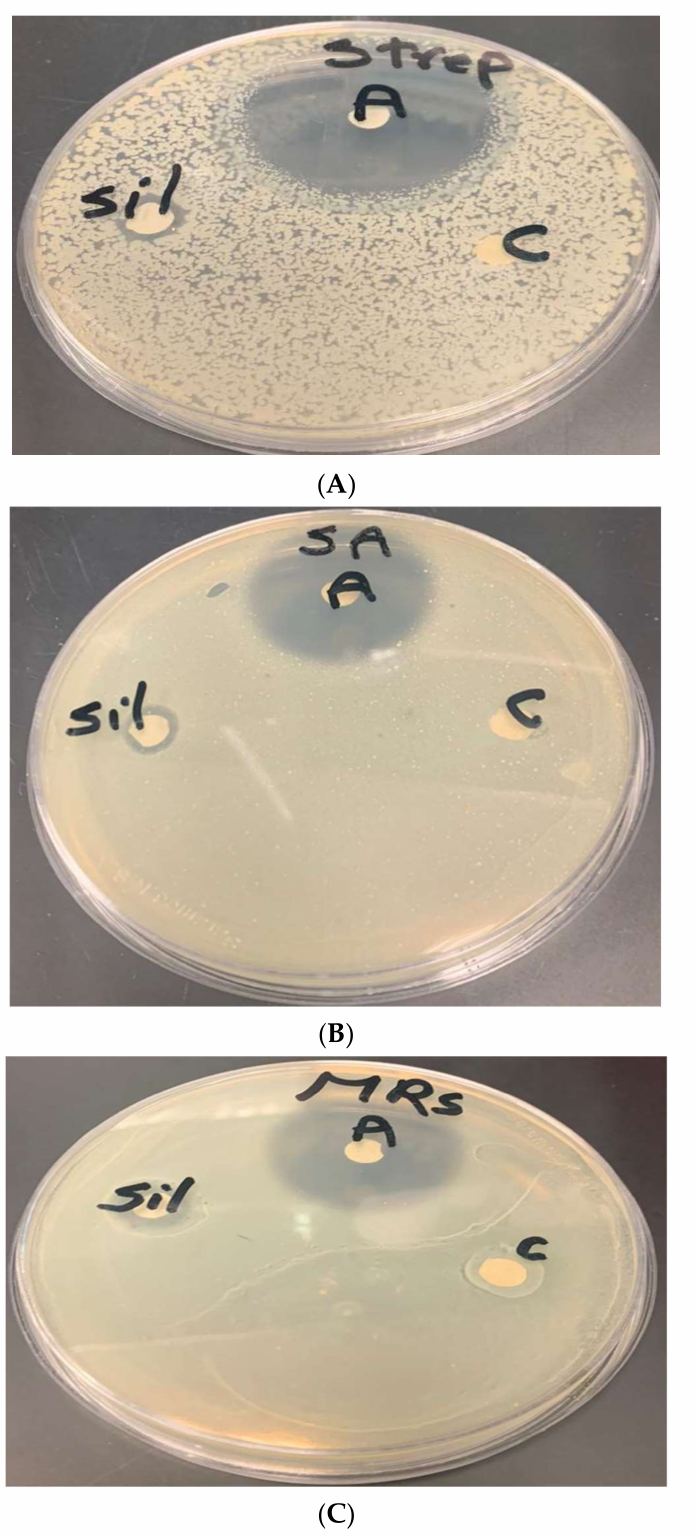
Figure 8. Inhibition zone of silver nanoparticles of Chlorella vulgaris extract against ( A ) Streptococcus sp., ( B ) Staphylococcus aureus , and ( C ) methicillin-resistant Staphylococcus aureus